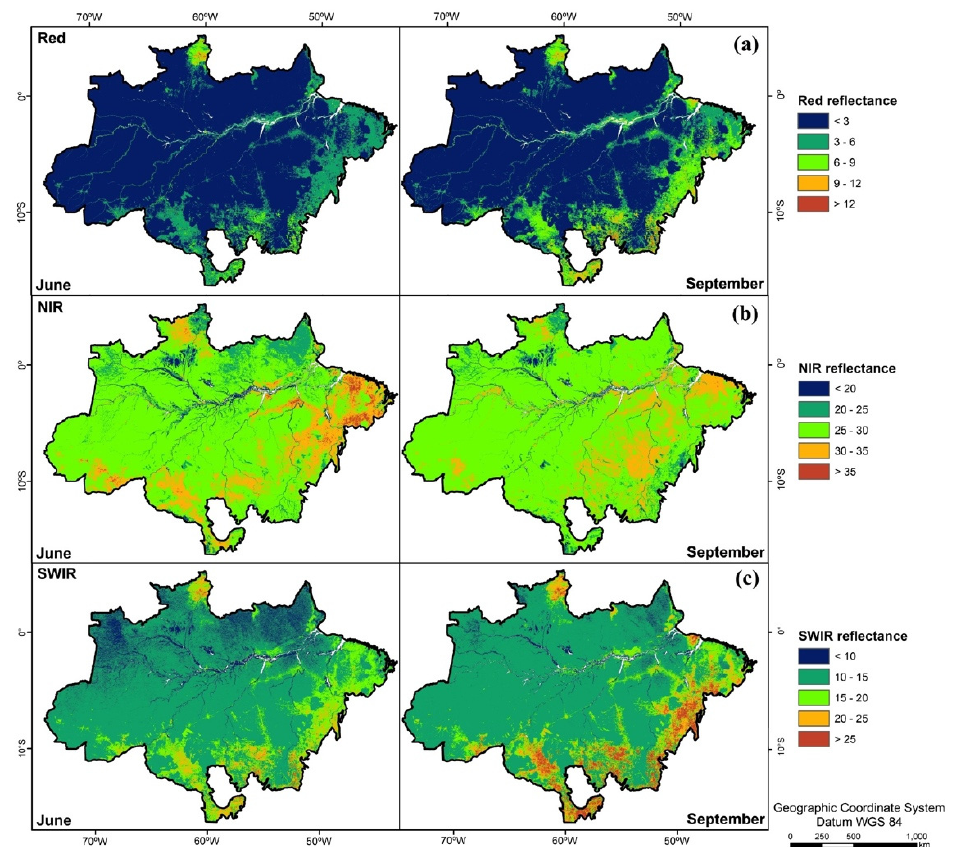
Figure 7. Variations in monthly average surface reflectance (2000–2014) for MODIS (MAIAC) data corrected for BRDF effects in bands ( a ) 1 (red), ( b ) 2 (near infrared – NIR), and ( c ) 6 (shortwave